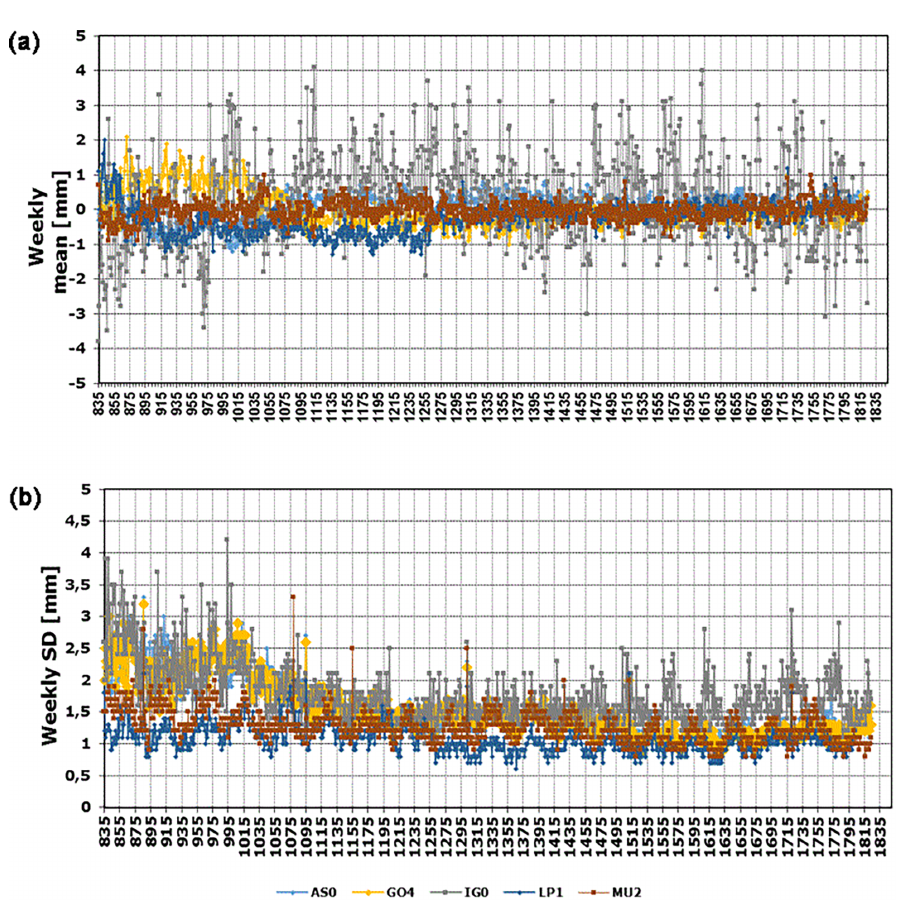
Figure 6. Weekly mean ZTD biases (a) and standard deviations (b) of each contributing solution with respect to the final EPN-Repro2 combination.